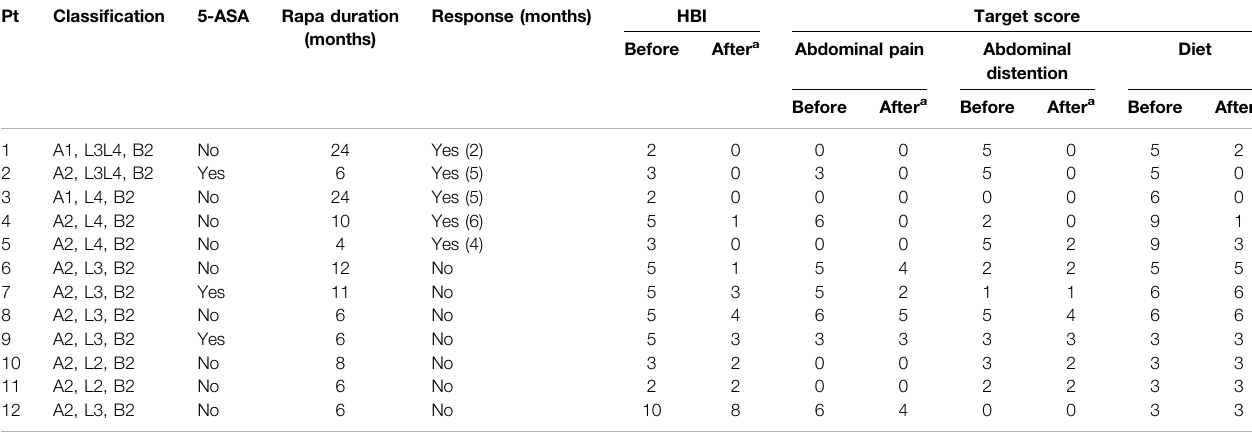
TABLE 3 | Medications and clinical outcomes of